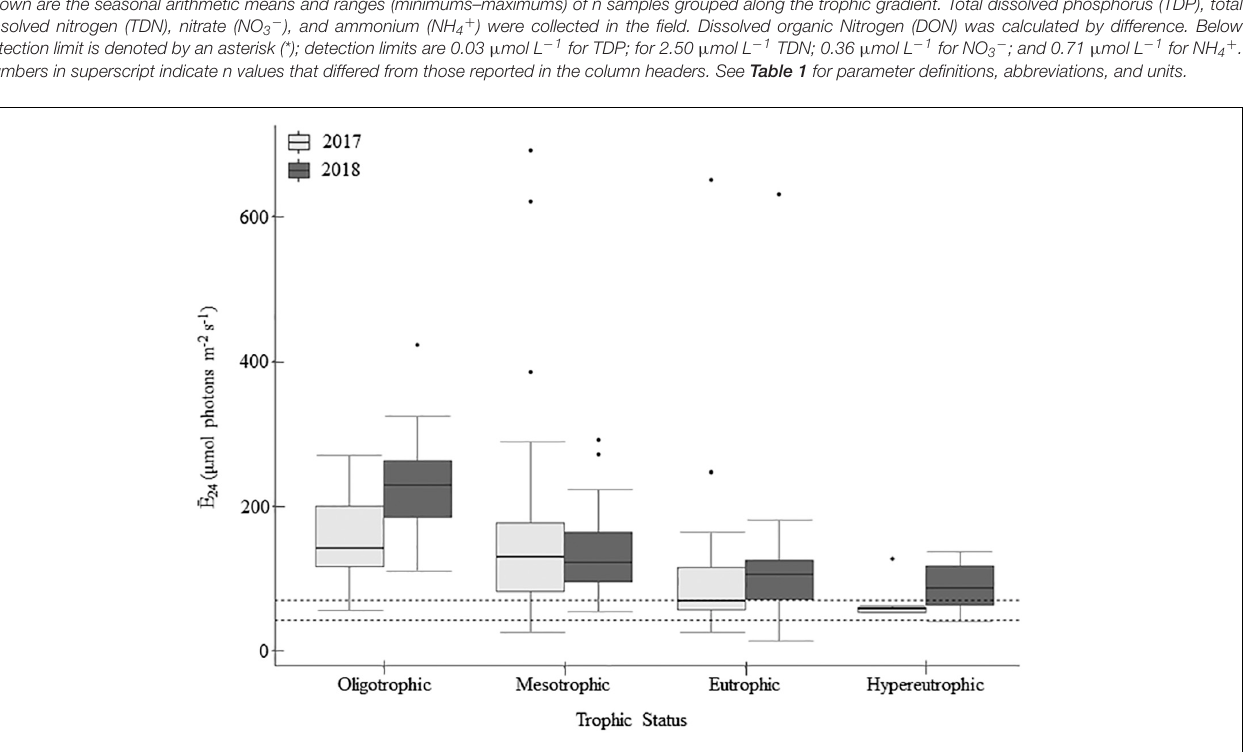
FIGURE 2 | Mean daily mixed layer irradiance (¯E 24 ) across trophic status during the 2017 and 2018 sampling seasons ( n = 213). Within the boxplots, the 50th percentile (median) is visualized with a solid horizontal line within each box. The 25th and 75th percentiles are represented by box hinges above and below the median line. On either end of the box, whiskers denote the smallest and largest values within 1.5 × the interquartile range (IQR) and points indicate values beyond 1.5 × the IQR. Dashed lines on the figure represent the light-deficiency thresholds, where values below the lines would be considered light deficient ( Table 2 ).